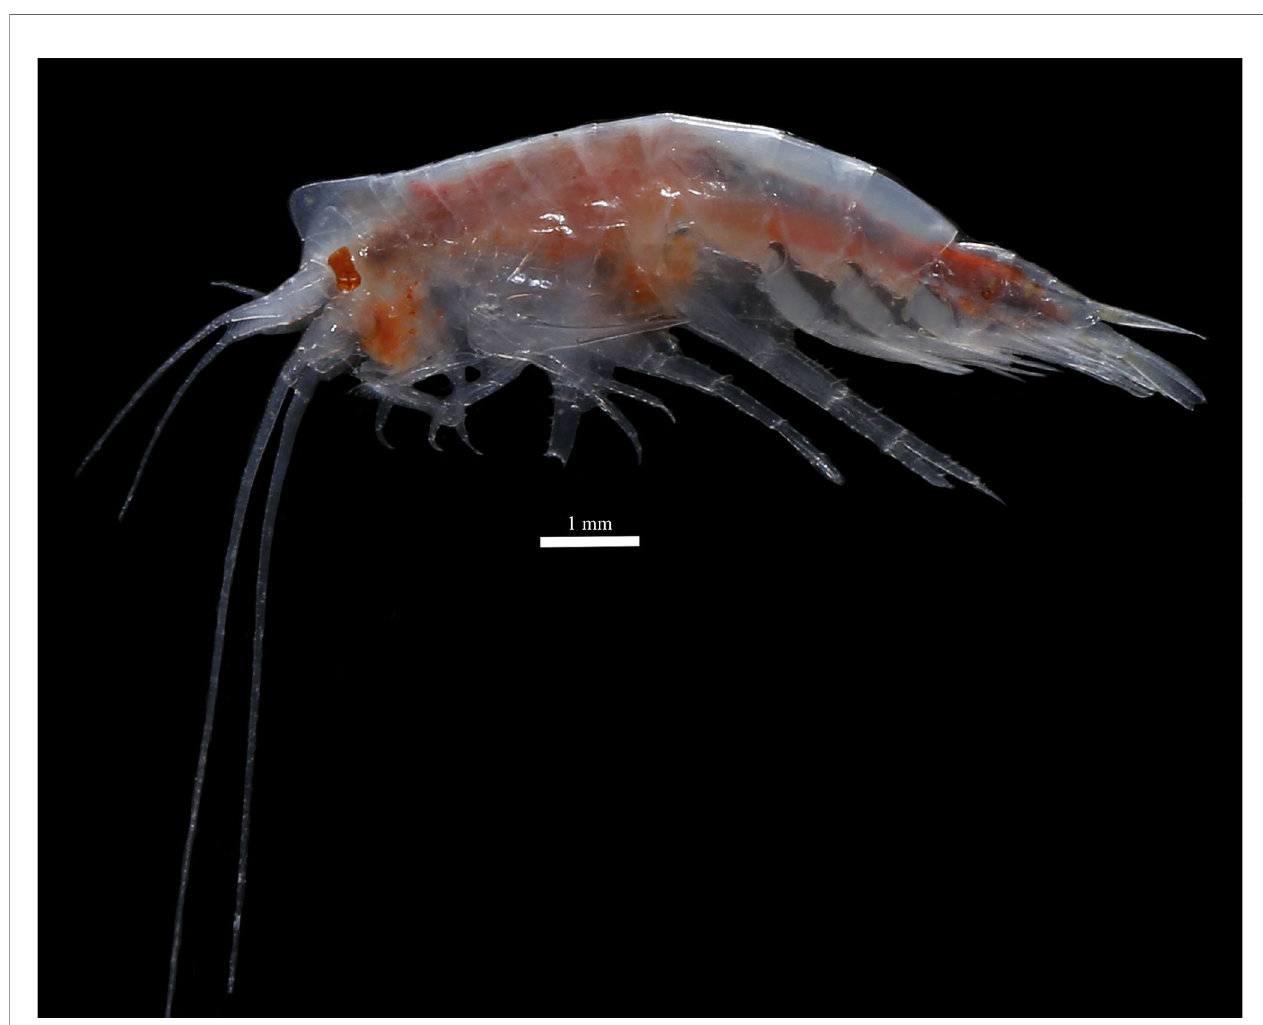
FIGURE 7 | Cyphocaris lubrica sp. nov., MBM 286819, male holotype (9.1 mm), photographed immediately after sorting from the zooplankton samples by Ziming